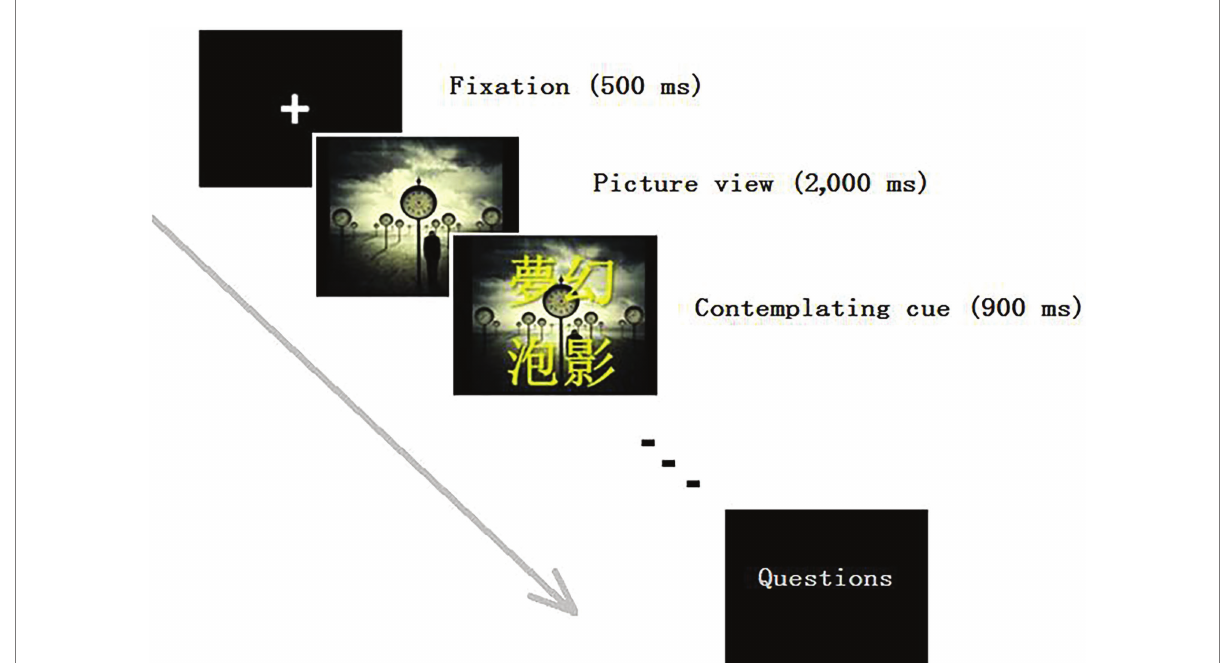
FIGURE 1 Design and timeline in the wisdom-compassion event-related potential